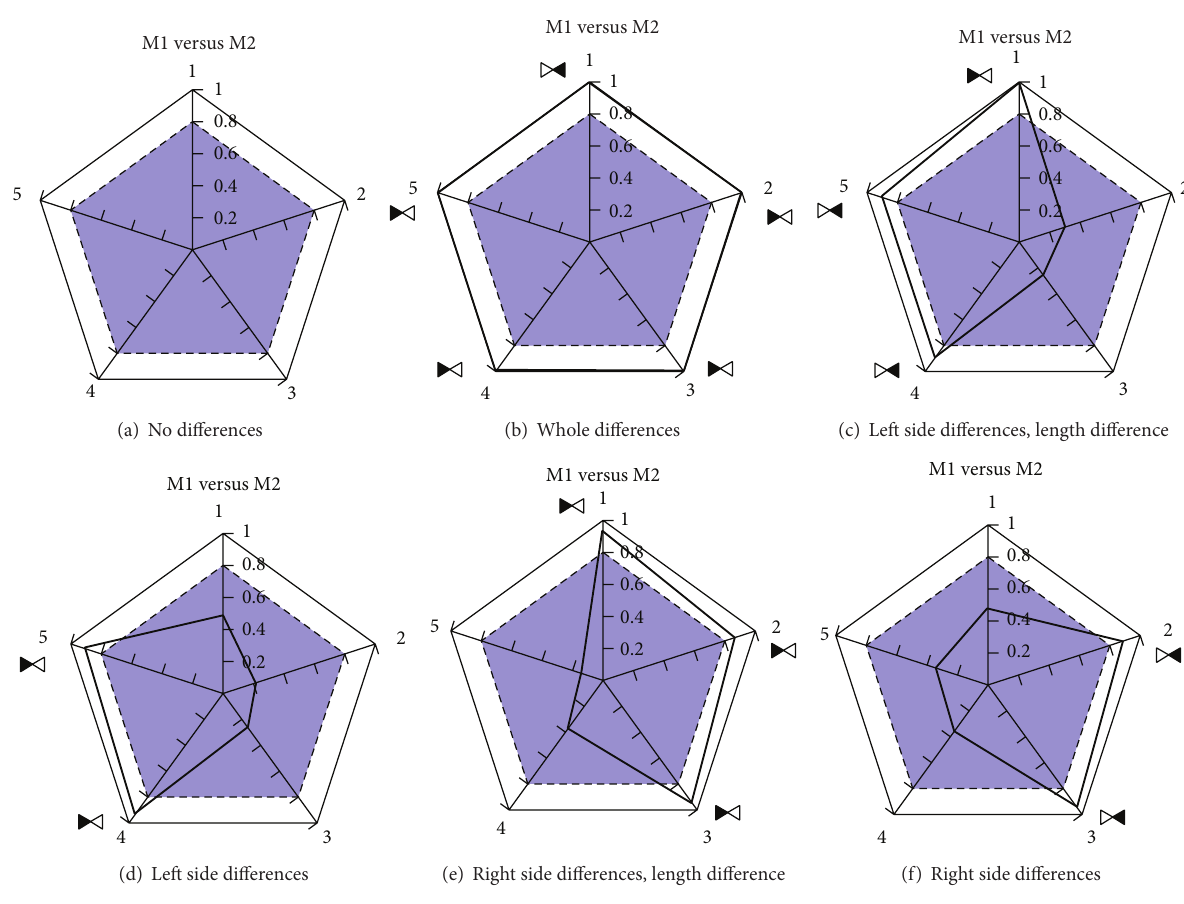
Figure 5: Pentagon like